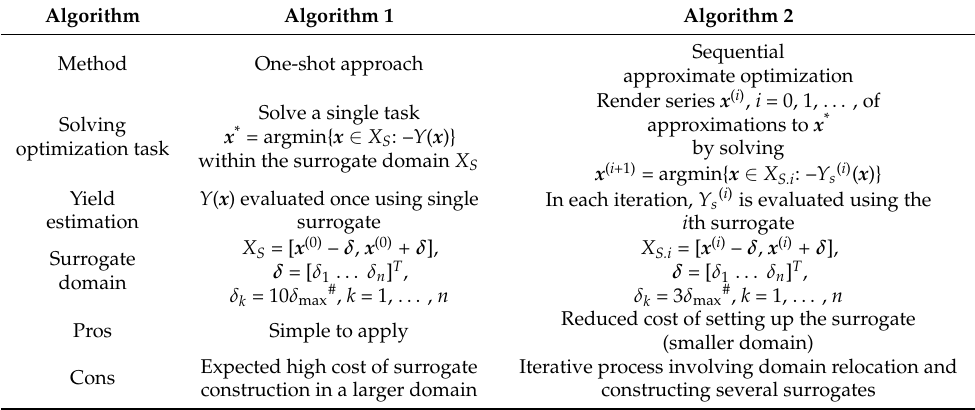
Table 1. Surrogate-assisted yield optimization: one-shot approach and sequential approximate